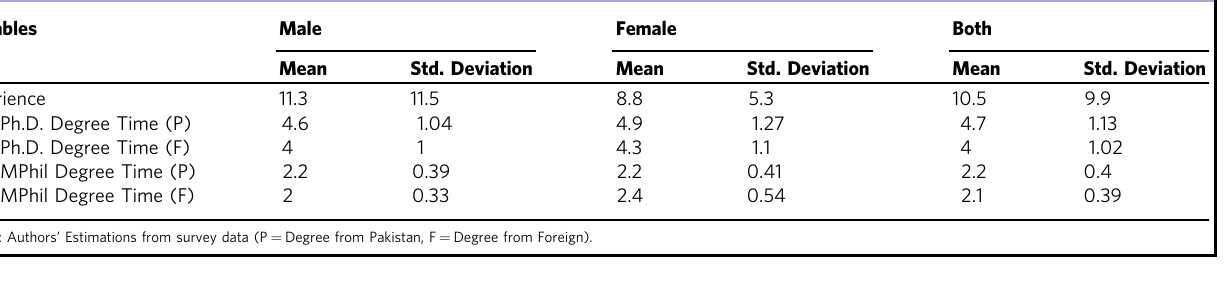
Table 4 Descriptive analysis by gender.